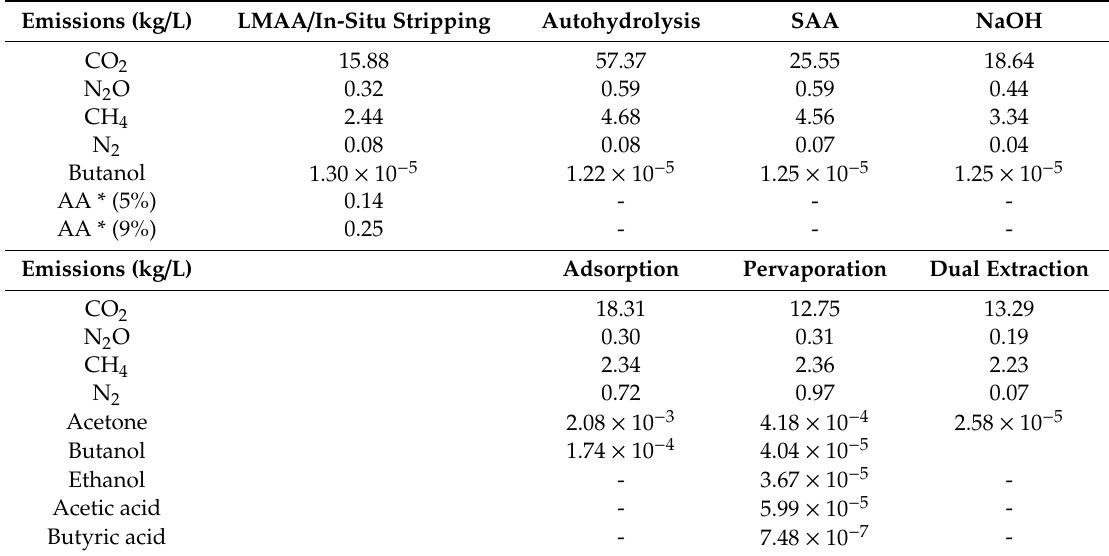
Table 1. Inventory of life-cycle emissions (to air) data for di ff erent cellulosic butanol production models. Emissions (kg / L) LMAA / In-Situ Stripping